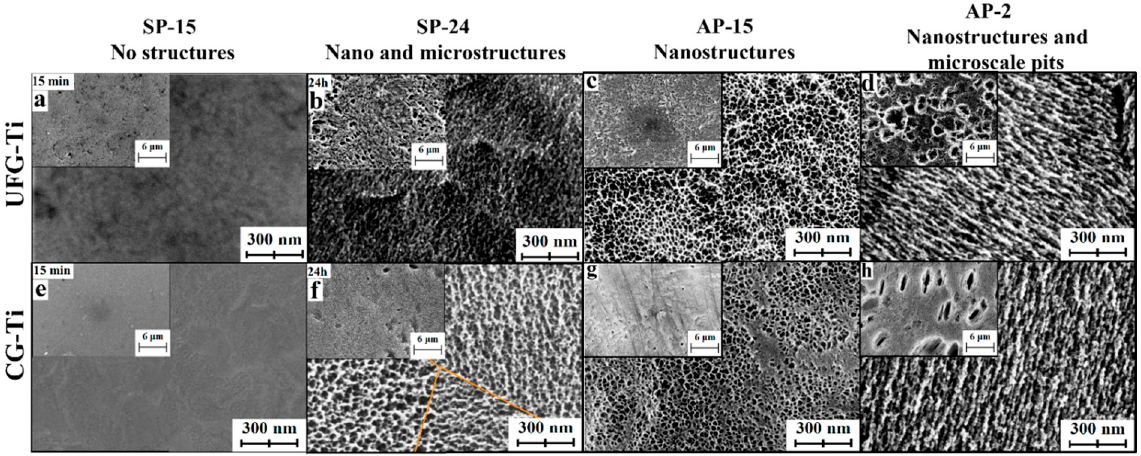
Figure 1. SEM images of chemically etched UFG and CG titanium discs: ( a ) UFG ‐ SP ‐ 15; ( b ) UFG ‐ SP ‐ 24; ( c ) UFG ‐ AP ‐ 15; ( d ) UFG ‐ AP ‐ 2; ( e ) CG ‐ SP ‐ 15; ( f ) CG ‐ SP ‐ 24; ( g ) CG ‐ AP ‐ 15; ( h ) CG ‐ AP ‐ 2. Reprinted with adaptation from [19].